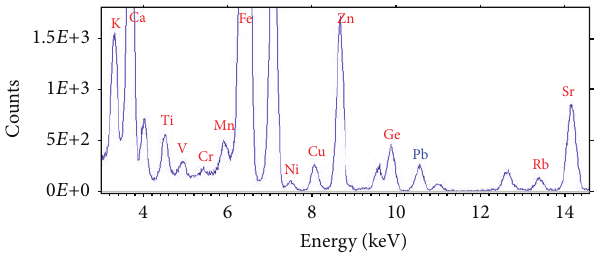
Figure 2: TXRF spectrum of a moss sample from Tollocan sampling site (6) at the Metropolitan Zone of the Valley of Toluca.